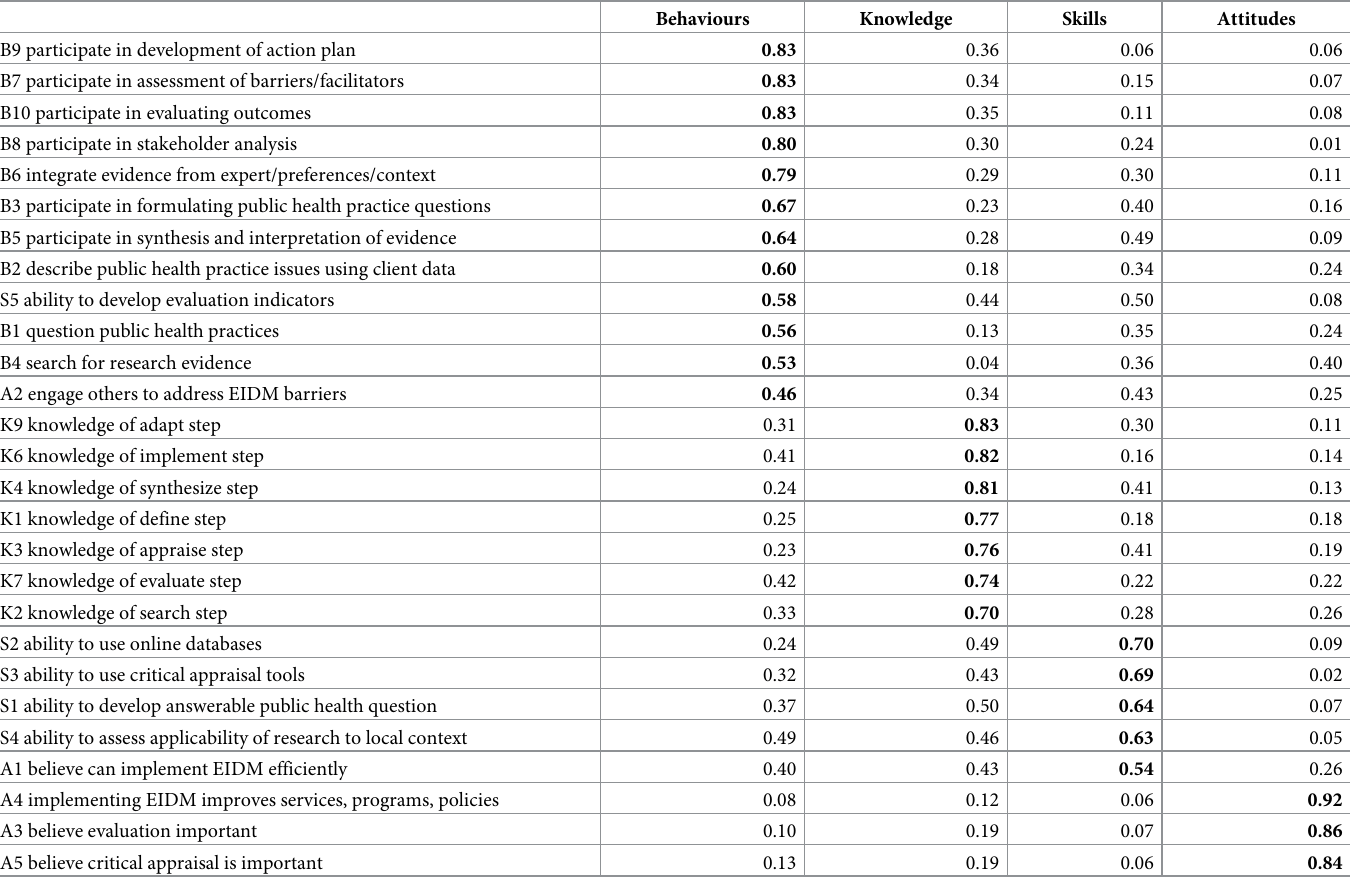
Table 4. Factor loadings for 27-item EIDM competence